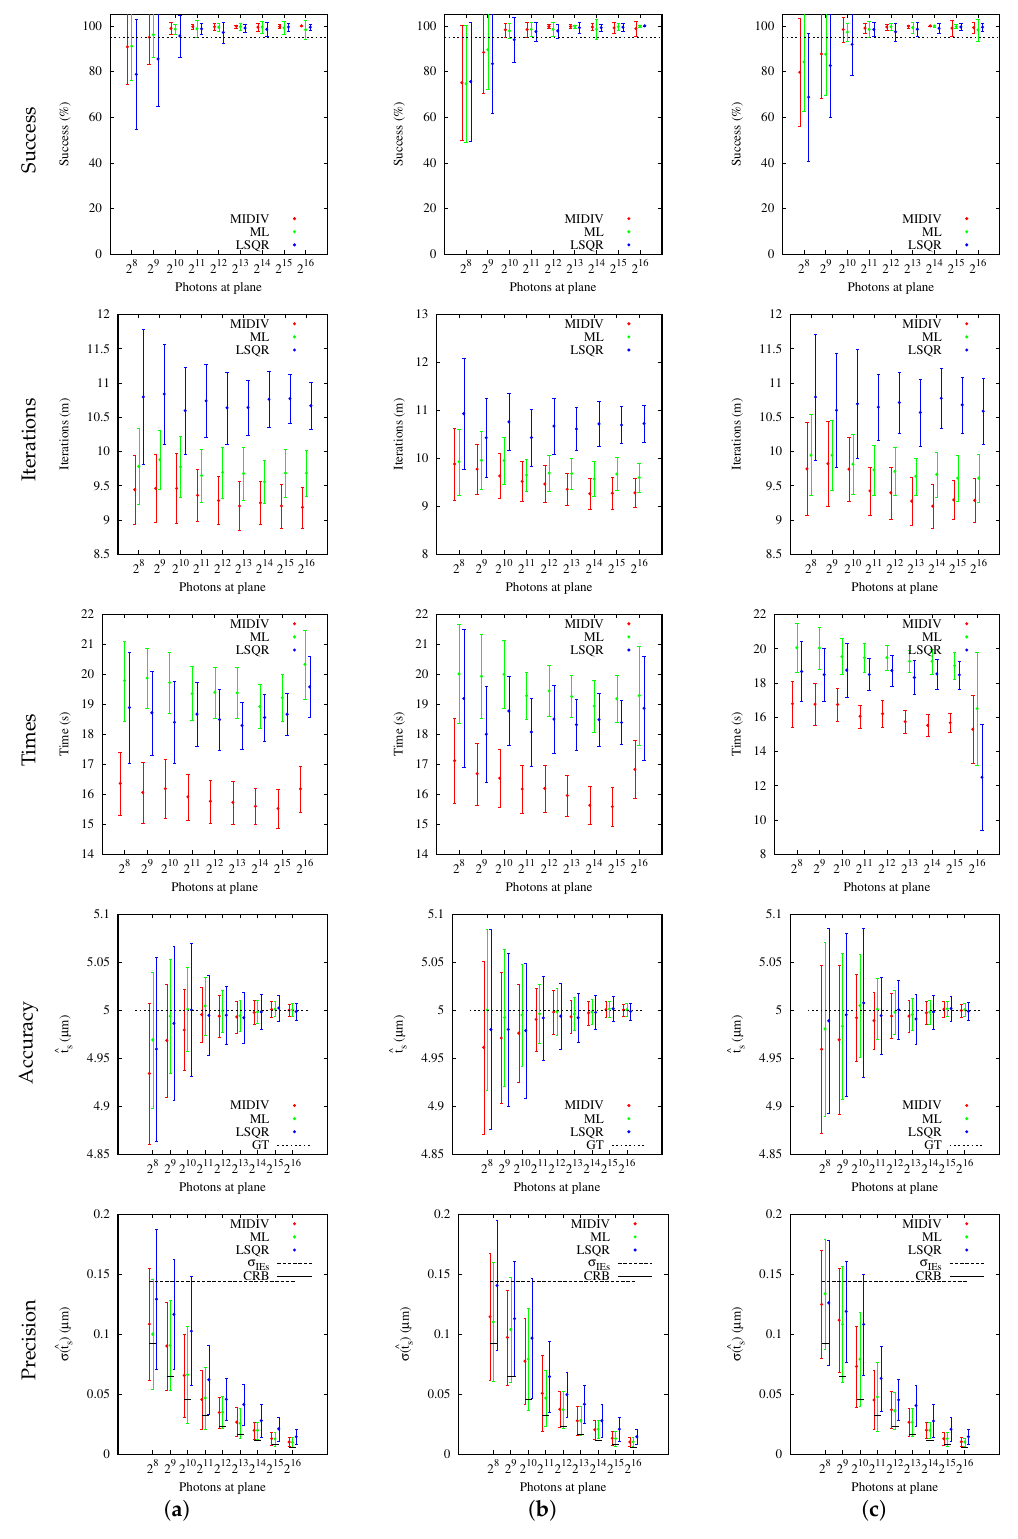
Figure 10. Optical axis estimation results of the methods: MIDIV (red), ML (green) and LSQR (blue). ( a ) NCI; ( b ) NCII; ( c )